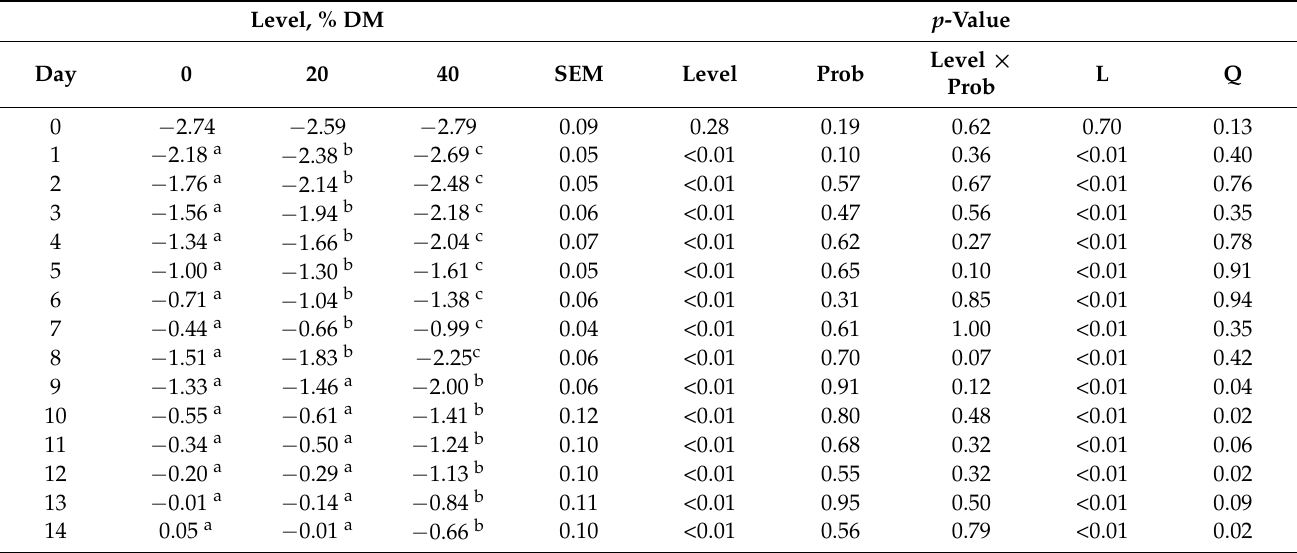
Table 4. Temperature differences between the ambient and silage temperature ( ◦ C) of sorghum ensiled with 0, 20, and 40% vegetable mixture, with or without a probiotic inoculant (Prob) under exposure to aerobic conditions for 14